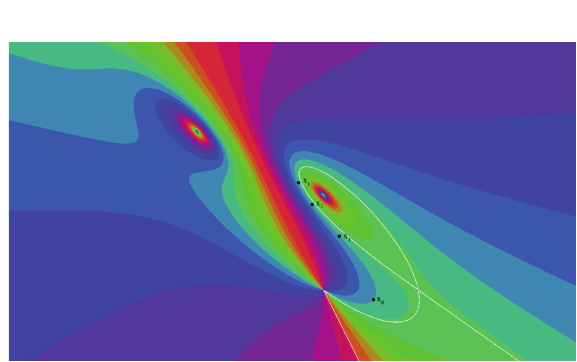
(cid:2) h (cid:3) x,y (cid:4) , so that